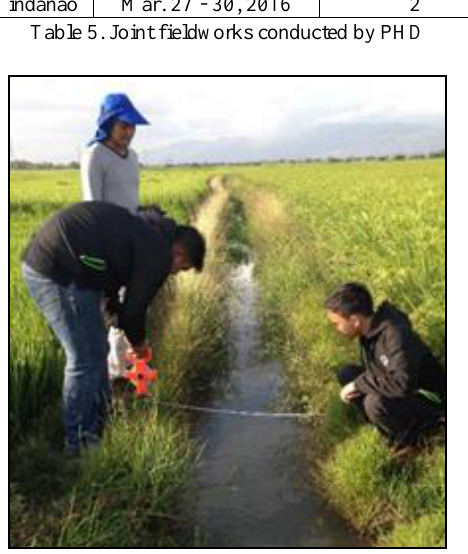
Figure 6. Joint field validation of CLSU and UPD